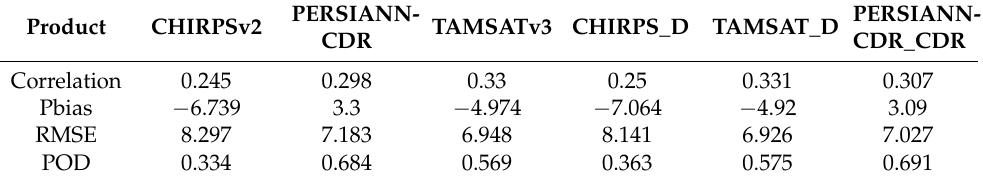
Table 3. Daily statistical indicators of validation.